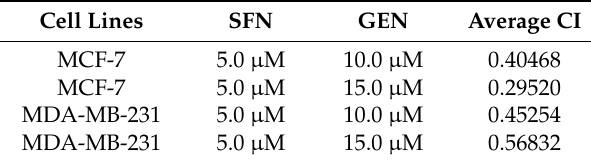
Figure 2. MTT assay. Combinatorial genistein (G) and sulforaphane (S) decrease cellular viability in breast cancer cells. ( A ) assays with 3-(4,5-dimethylthiazol-2-yl)-diphenyl tetrazolium bromide (MTT) of MCF-7 breast cancer cells were performed using several individual doses of GEN and SFN at different concentrations as well as their combination for 3 days; ( B ) MTT assays were performed on MDA-MB-231 cells for three days using the indicated concentrations; ( C ) MTT assays were performed on MCF10A cells for three days using the individual and combinatorial doses. The results represent three separately cultured experimental replicates. Numbers on the x -axis indicate compound concentrations (* p < 0.05, ** p < 0.01, *** p < 0.001, G, GEN; S, SFN). Data are presented as mean ± standard deviation (SD). Table 1. CompuSyn data of MTT values indicate synergism in breast cancer cells.